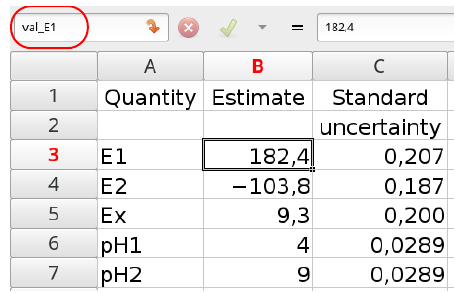
Figure 3. A table in a spreadsheet containing the input data and their